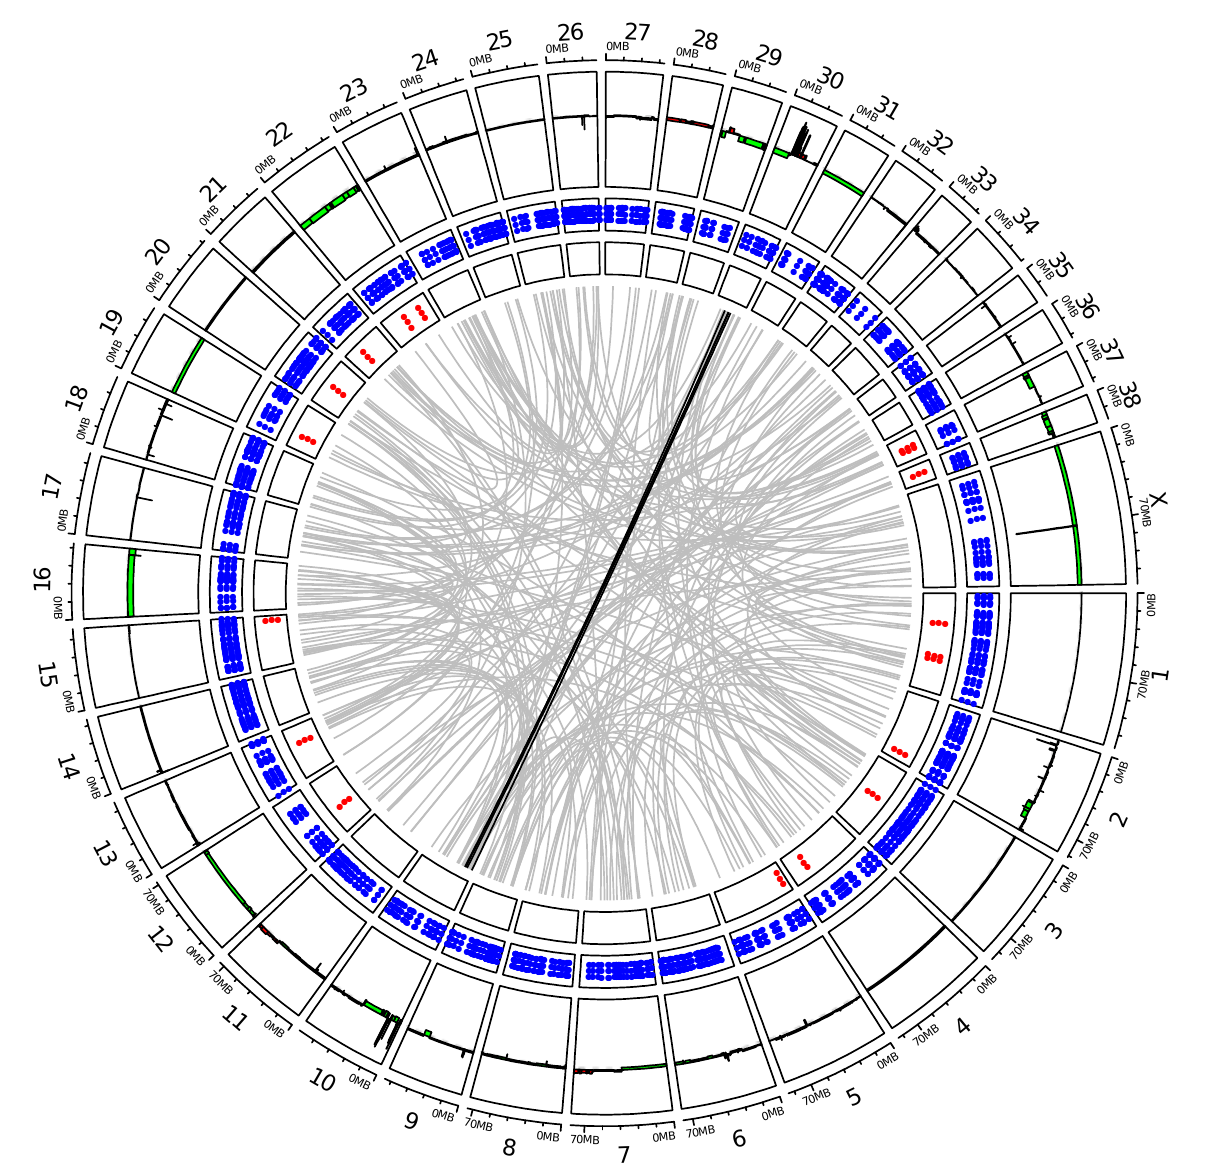
Figure A3. Circos plot representing the distribution of SVs of cell line Bear along dog chromosomes with, from external to internal layers, CNA gains/losses (in dark red/green), deletions, duplications, insertions, and inversions in blue, light red, orange, and green, respectively. Interchromosomal break-ends (BND) are represented by gray lines connecting chromosomes with a color intensity corresponding to the number of reads validating the SV.